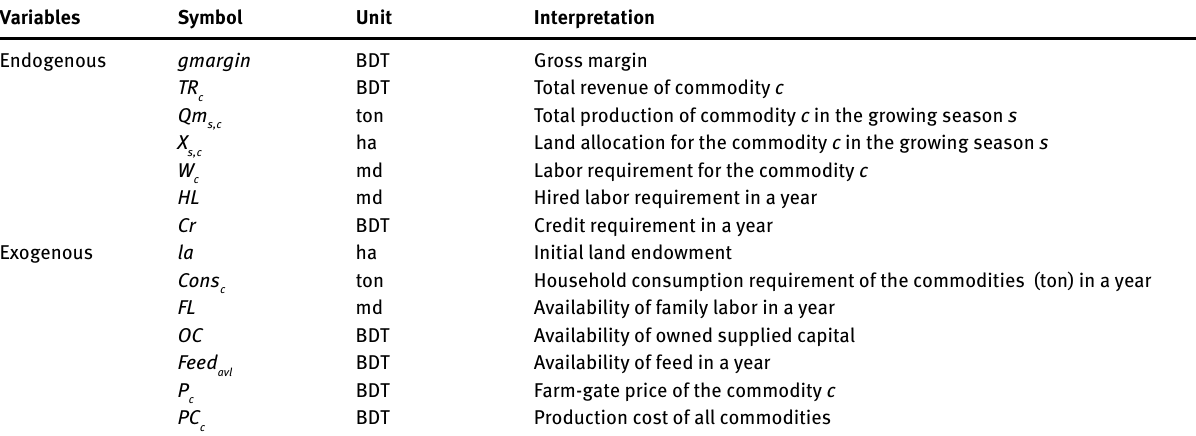
Variables Symbol